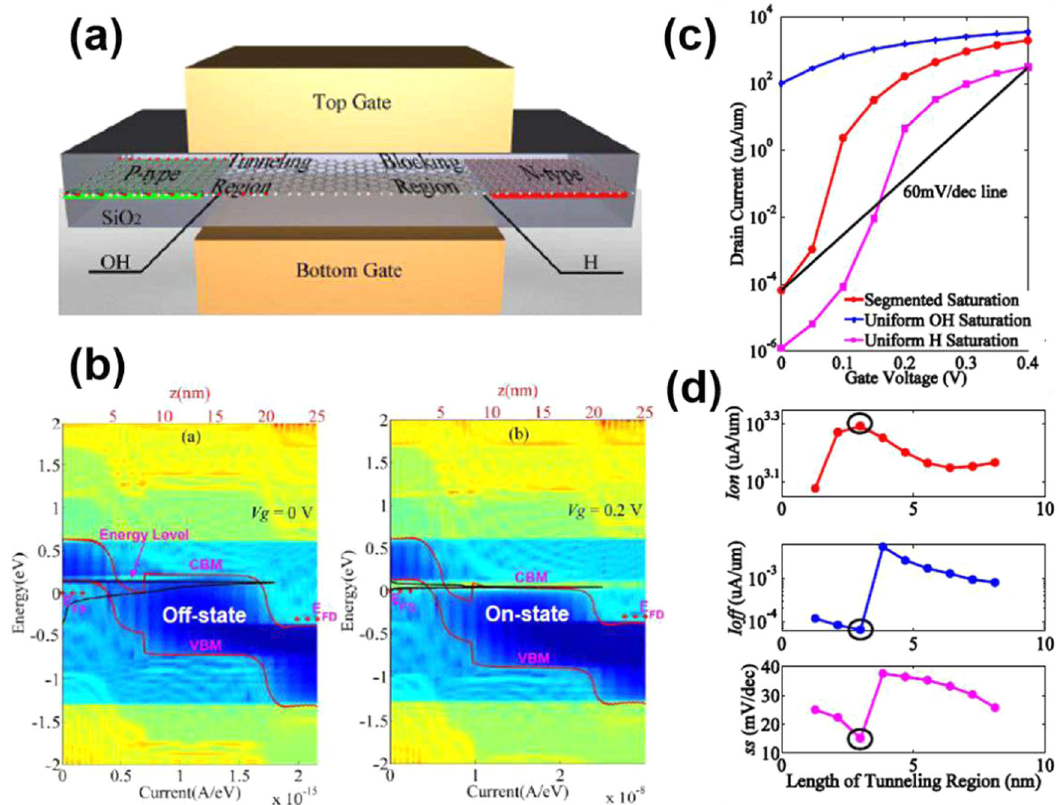
Fig. 10 Simulation Report of Nanoscale 2D GrNR-TFET. a Schematic of selective edge saturated gate hetero-structure GrNR-TFET and subsequent b lateral band-pro fi les at on-state and off-state, c transfer characteristics d performance optimization with tunneling region length, adapted with permission from 82 . Copyright (2017)